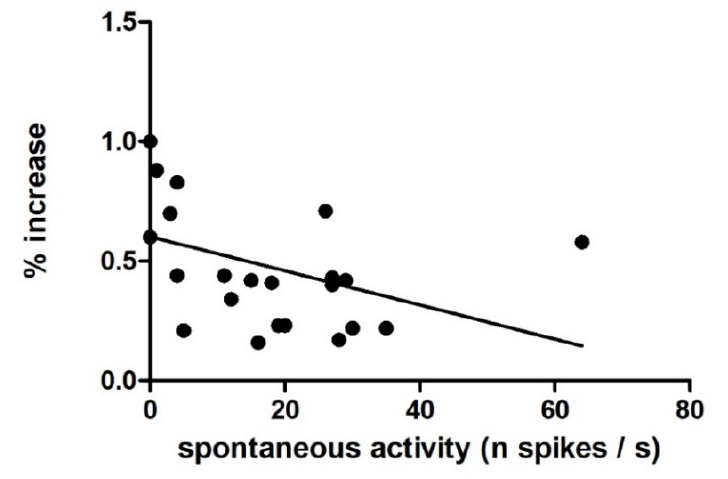
Figure 4. Relation between spontaneous activity of neurones and food odour evoked activation. For those 23 food odour excited neurones of Figure 3A, each point displays the percent increased activity upon food odour stimulation (y-axis) plotted versus the mean spontaneous activity (x-axis). There is a significant correlation between the 2 variables (Spearman r = − 0.5744, p = 0.0041).